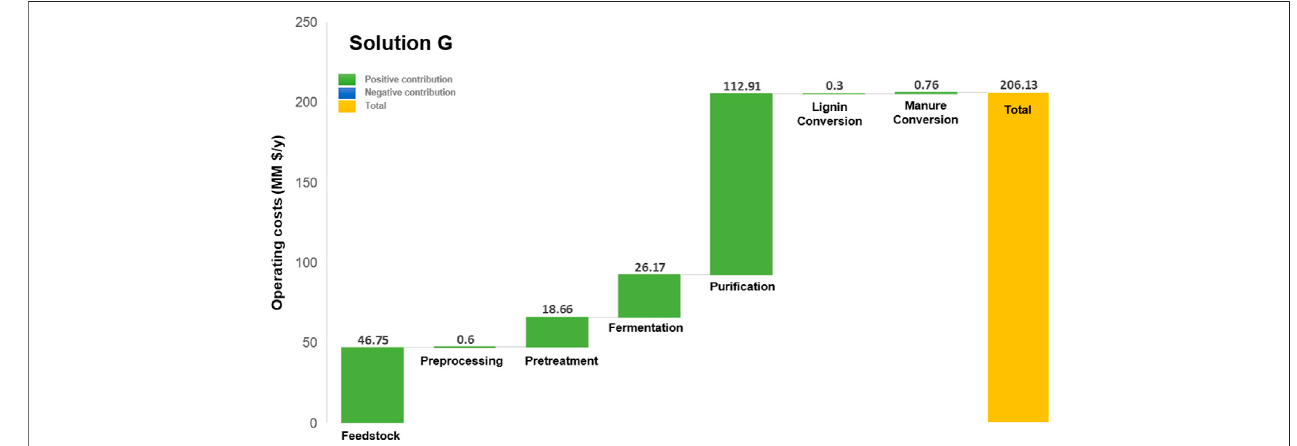
FIGURE 10 | Solution G: operating cost by processing step.